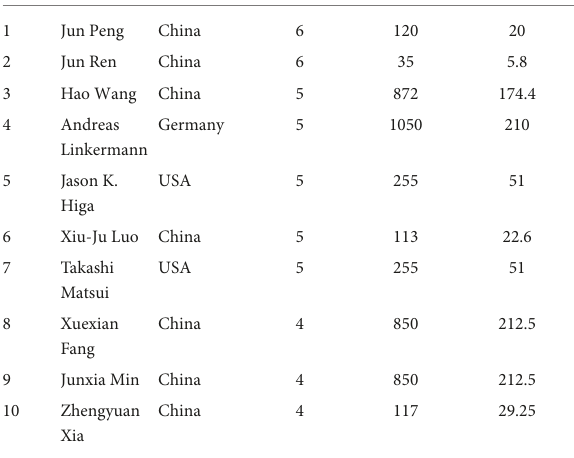
TABLE 3 Summary of the top 10 authors.